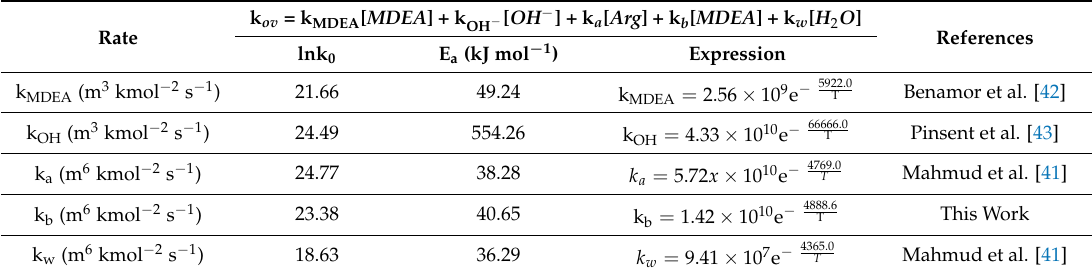
Table 9. Summarized kinetics rate constants for CO 2 -MDEA-Arg reaction using Termolecular Mechanism.